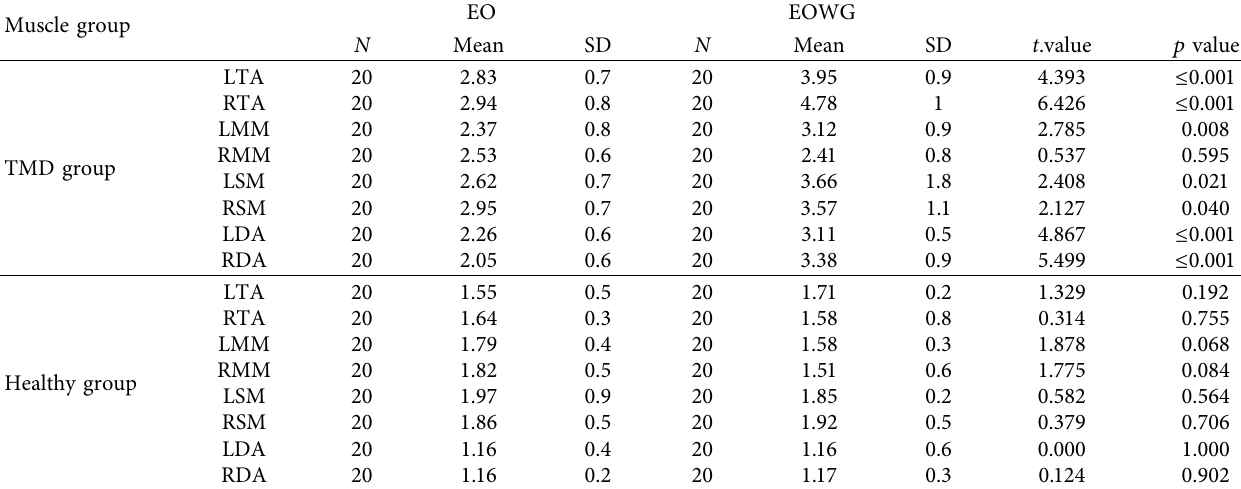
Table 6: EMG values of the individual muscles with eyes open with and without glasses on. Muscle group